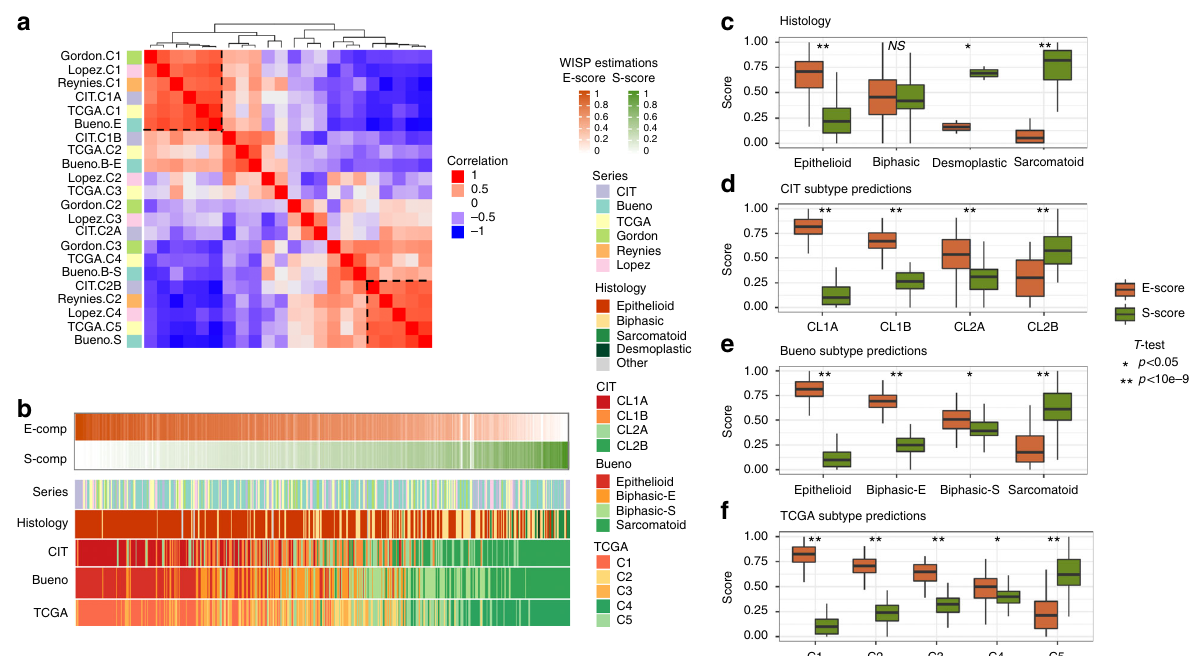
Fig. 1 Meta-analysis and molecular gradients. a Correlation matrix of centroid pro fi les of all clusters from the different classi fi cations. b Estimation of the E - score and S -score and classi fi cation subtype predictions in all available tumor tissue samples (442 samples). The samples were ordered based on their E - score and S -score ratios. c – f Boxplots of the E -score and S -score according to the histology results ( c ), CIT subtype predictions ( d ), Bueno subtype predictions ( e ), and TCGA subtype predictions ( f ). Signi fi cance in the T -test comparing the E -score and S -score in each modality is shown (* P value < 0.05, ** P value < 10e − 9, NS, not signi fi cant). For all boxplots ( c , d , e , f ), bottom and top of boxes are the fi rst and third quartiles of the data, respectively, and whiskers represent the lowest (respectively highest) data point still within 1.5 interquartile range of the lower (respectively upper) quartile. Center line represents the median